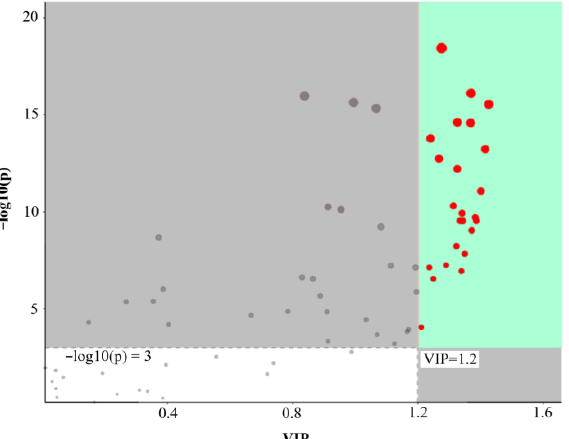
Figure 5. Differential metabolites were detected at the three developmental stages of apricot endocarp based on the (variable importance for the projection) VIP and p values using the PLS-DA model. Each dot represented a metabolite, and the red dot is the metabolite with significant difference among different stages. Table 3. Differential metabolites screened at the three developmental stages of apricot endocarp.